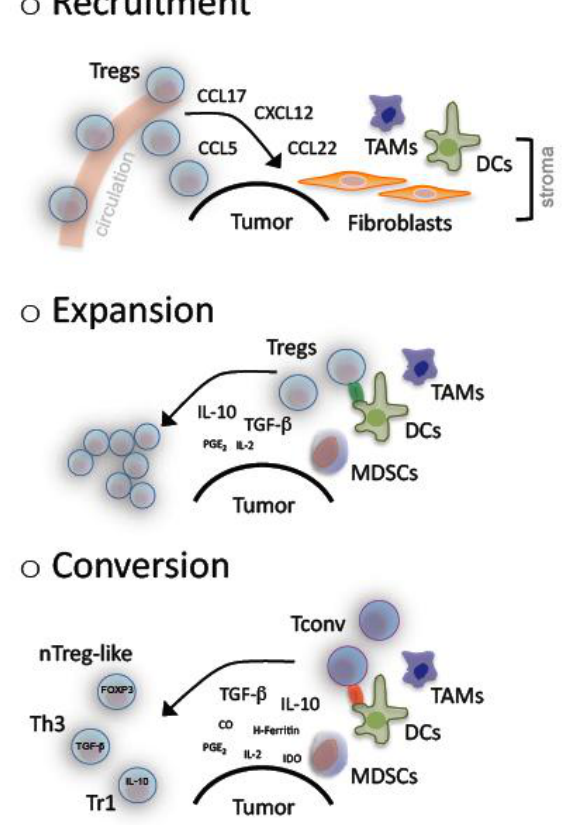
Figure 1. Accumulation of regulatory T cells in cancer. A number of mechanisms lead to the observed accumulation of regulatory T cells (Tregs) in cancer. Malignant cells and/or bystanding fibroblasts, dendritic cells (DCs) as well as tumor associated macrophages (TAMs) in the tumor stroma produce and secrete several chemokines, which are chemoattractive for Tregs and result in their recruitment from the circulation away to the tumor site. Pre-existing Tregs can clonally expand upon antigen-specific activation in presence of mainly TGF-β and IL-10 that are regularly found at high levels within the tumor microenvironment. These two cytokines together with a suboptimal antigen presentation that is provided by tolerogenic DCs, TAMs and/or myeloid derived suppressor cells (MDSCs) additionally promote the conversion of conventional T cells (Tconv) into suppressive, adaptive Tregs including naturally occuring (n) Treg-like, T helper (h) 3 and T regulatory (r) 1